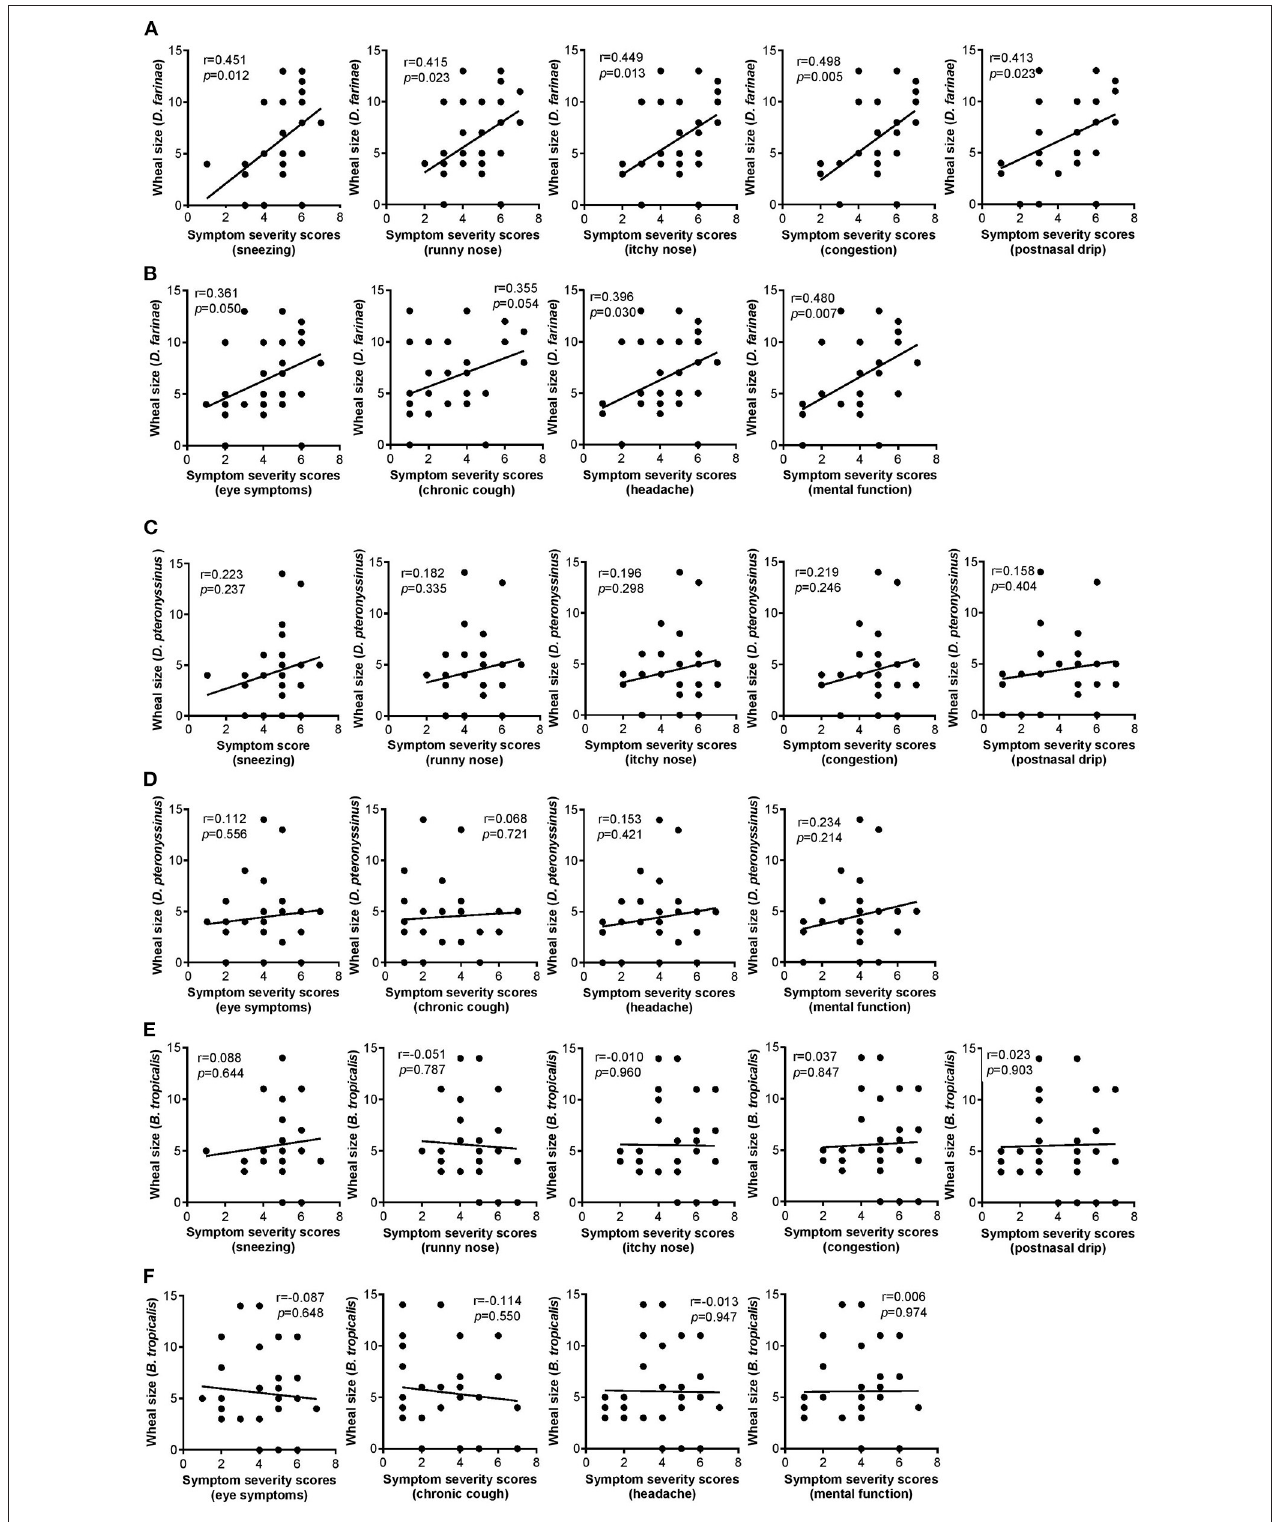
FIGURE 1 | (A,B) Correlation of wheal sizes of D. farinae sensitization with nasal (A) and non-nasal (B) symptom severity scores in AR patients ( n = 30). (C,D) Correlation of wheal sizes of D. pteronyssinus sensitization with nasal (C) and non-nasal (D) symptom severity scores in AR patients ( n = 30). (E,F) Correlation of wheal sizes of B. tropicalis sensitization with nasal (E) and non-nasal (F) symptom severity scores in AR patients ( n = 30).